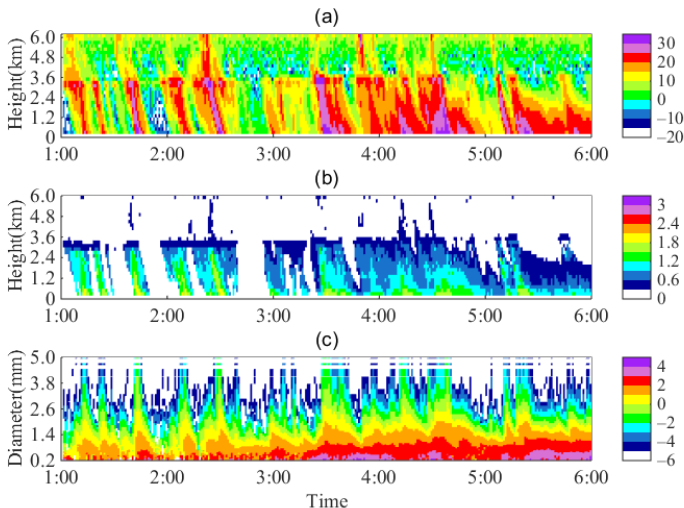
Figure 3. Time–height cross-sections of stratocumulus rain detected by MRR from 0100-0600 (UTC) on16 June 2021: ( a ) reflectivity factor (Z) (dBZ), ( b ) mass-weighted mean diameter ( D m ) (mm) and ( c ) DSD at 400 m (mm −1 m −3 on log scale).